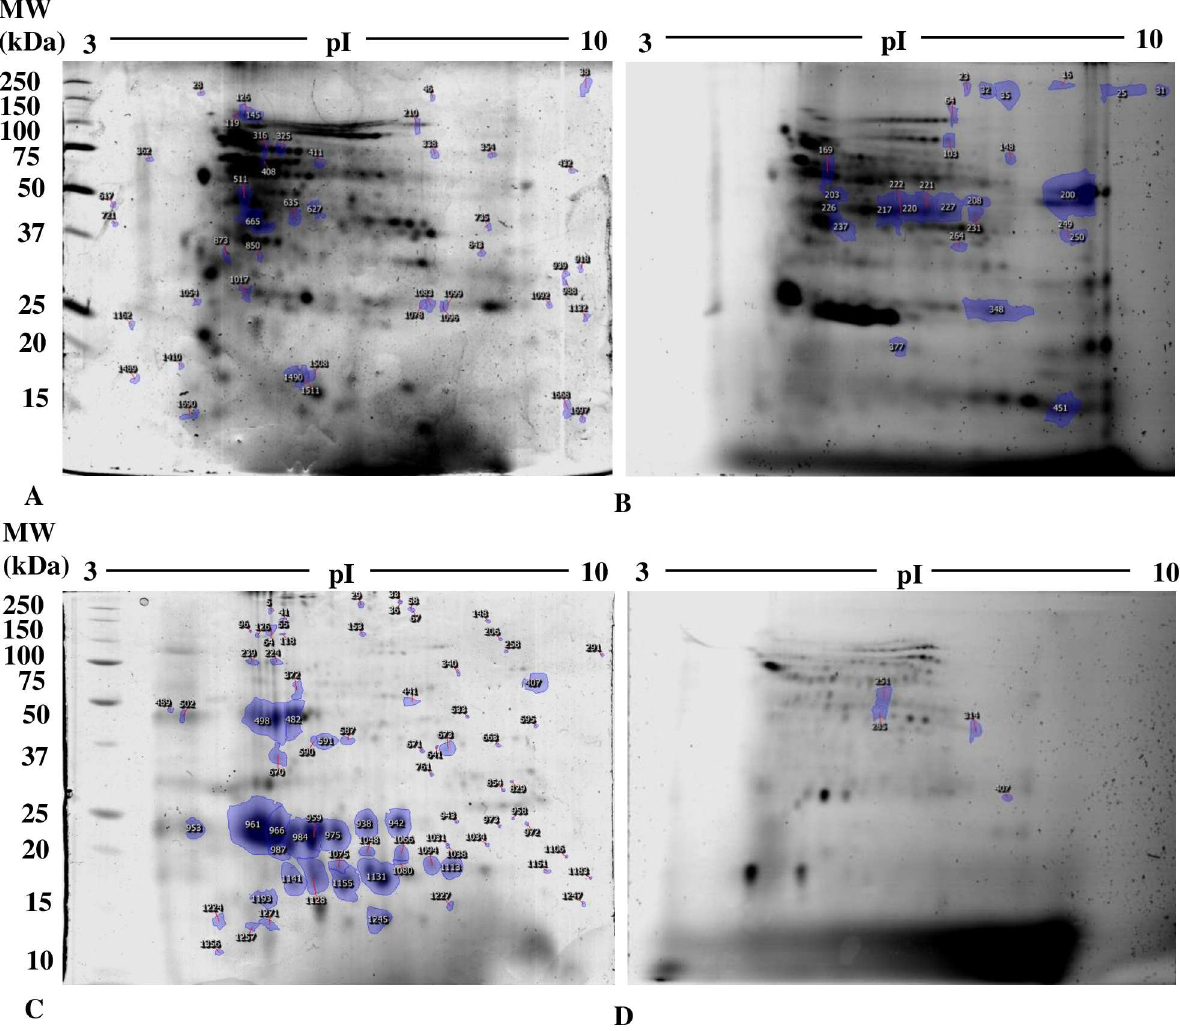
Fig 6. Profiles of the expression of proteins containing thiol groups in (A, B) seedlings and (C, D) cotyledons of bean seeds germinated for 9 days in the presenceof distilled water (CTR) or 200 μ M Cu. Proteins(800 μ g) were labeledwith IAF and separated by 2-D SDS-PAGE. Figures show spots of interest in representative gels from (A, C) colloidalCoomassie BrilliantG-250 staining (scanned with GS-800 calibrateddensitometer) and (B, D) IAF labeling(scanned with Typhoon9400 scanner; 800 PMT). Numbers correspondto spots of p < 0.05and Fold induction > 1.5 (spots